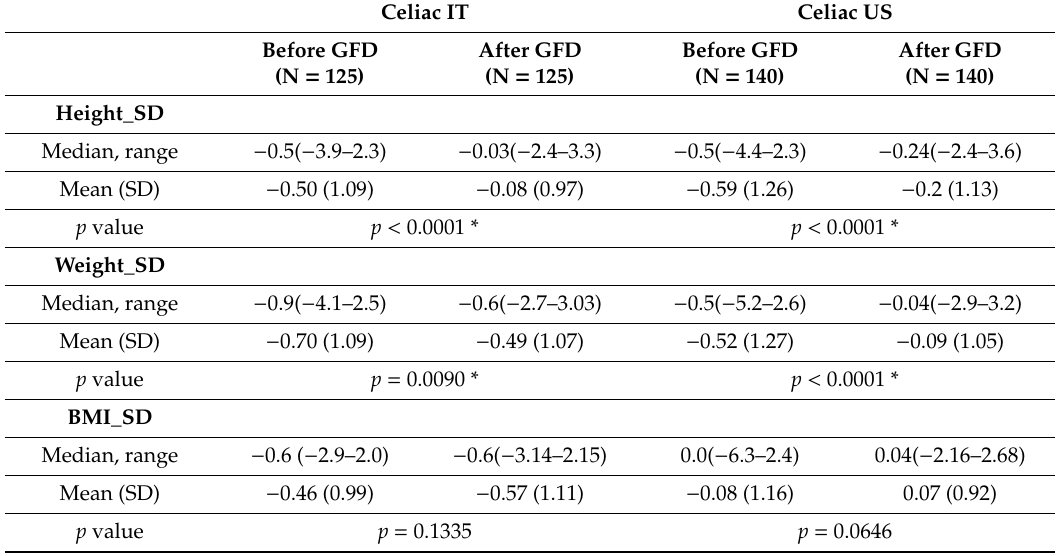
Table 3. Changes of anthropometric parameters over time in celiac